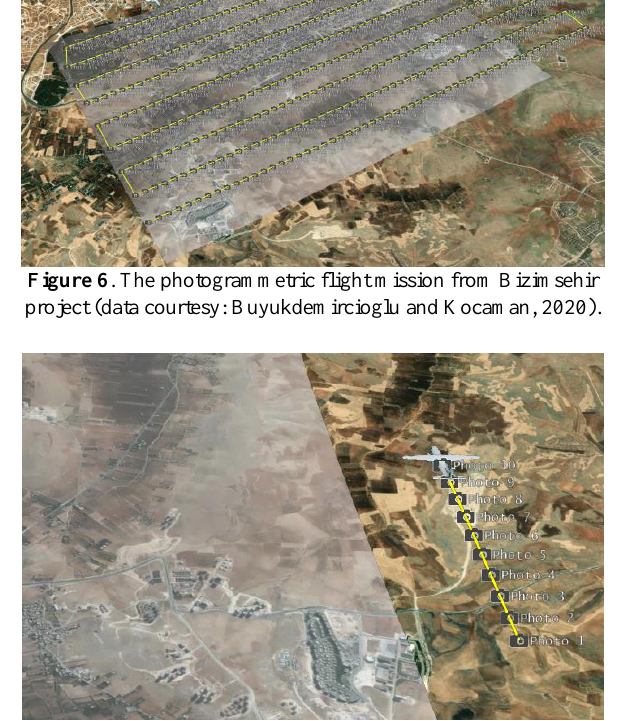
Figure 7 . A zoomed view of the aerial photogrammetric flight (data courtesy: Buyukdemircioglu and Kocaman, 2020).